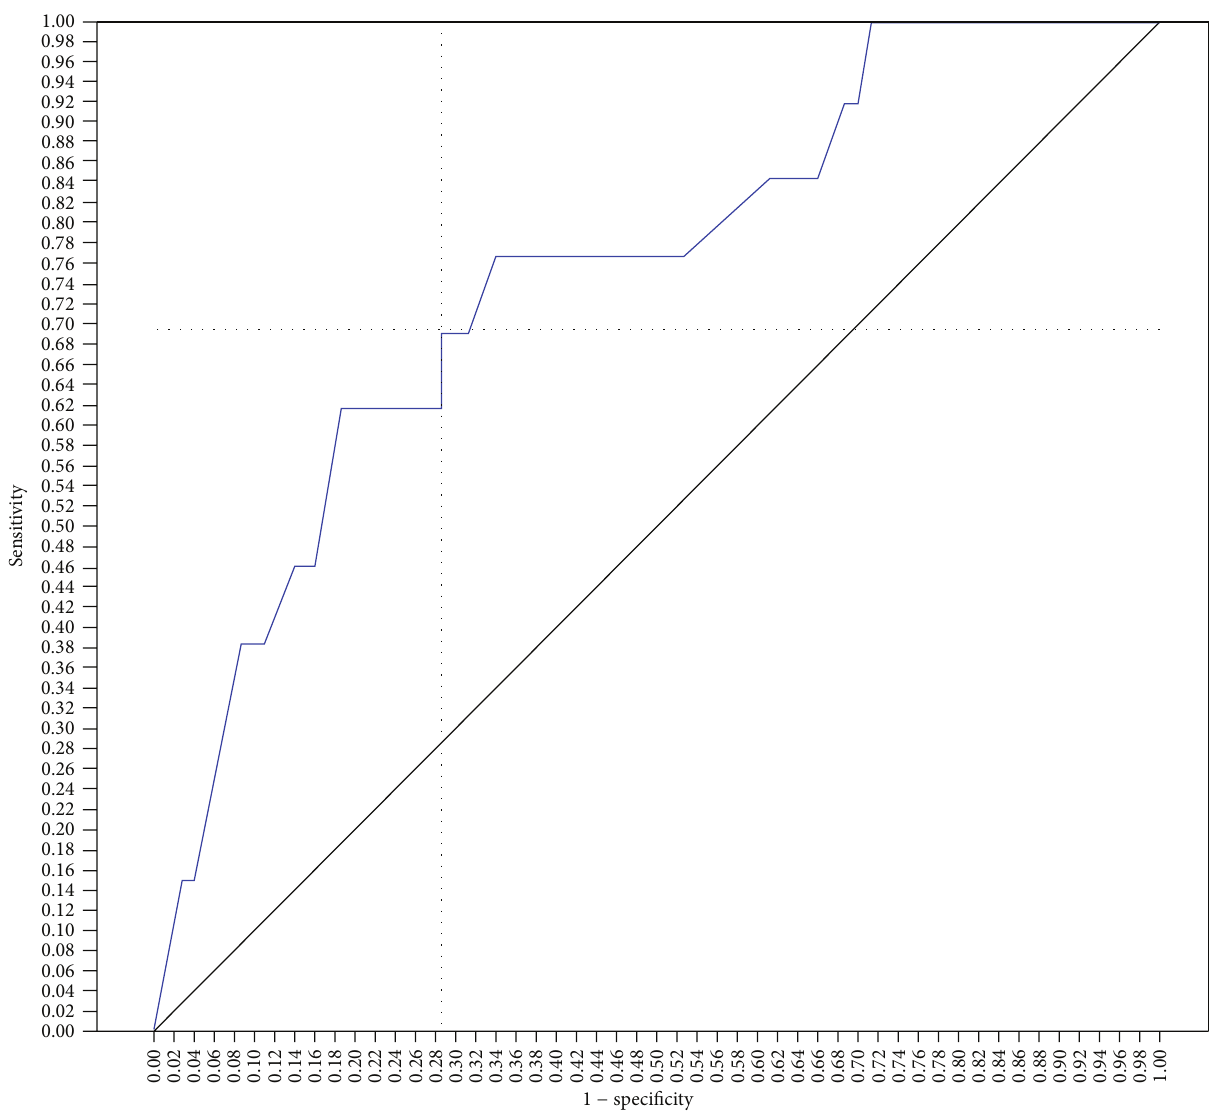
Figure 1: SAPS II ROC curve for prediction of hospital mortality. The score of 44 showed better sensitivity (77%) and specificity (65%) for hospital mortality, with an area under the curve of 0.75 (area = 0.5; 𝑃 < 0.004 , 95% CI;